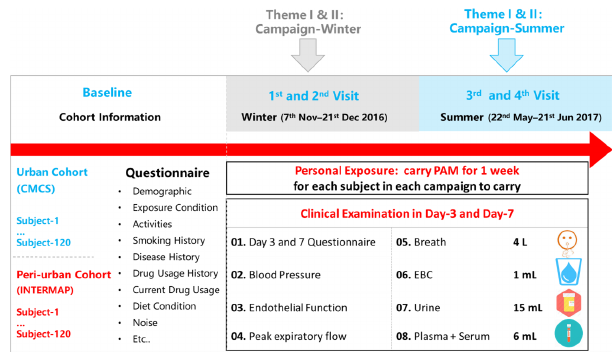
Figure 4. Scheme of clinical examination of